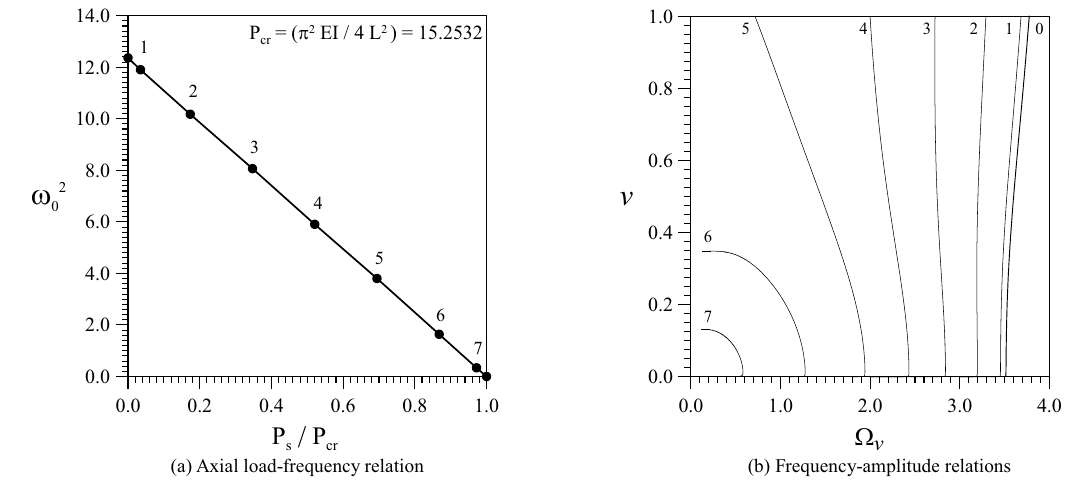
Fig. 2. Influence of axial static load on the lowest natural frequency and on the nonlinear frequency-amplitude